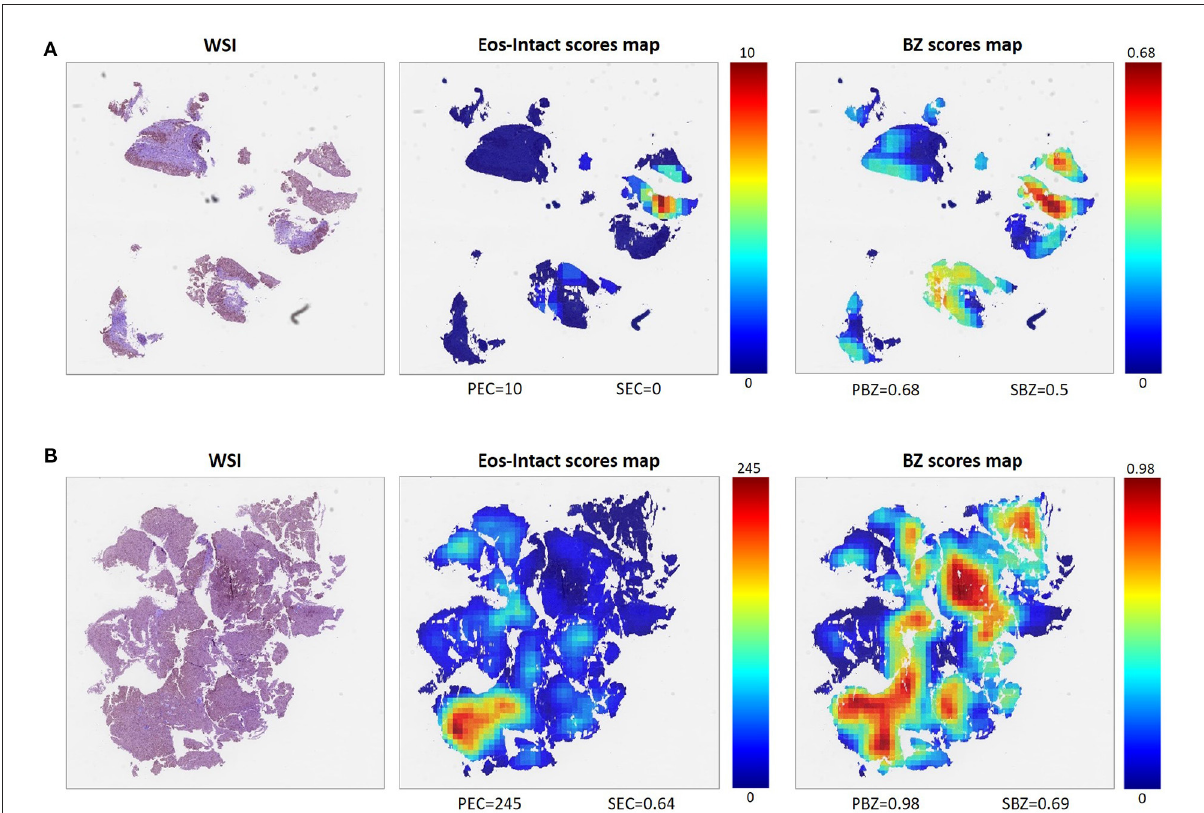
FIGURE3 Examples of two different WSIs (left) and their corresponding scores maps with scale for each score defined (middle, right). Each pixel in these maps represents one HPF, and the color of the pixel indicates the respective score. From the Eos-Intact scores map (middle), we extracted peak eosinophil count (PEC) and spatial eosinophil count (SEC). From the basal zone (BZ) score map (right), we computed peak basal zone (PBZ) and spatial basal zone (SBZ) scores. (A) Example of a WSI of a biopsy obtained from an EoE patient with inactive disease (PEC = 10). (B) Example of a biopsy obtained from a patient with active EoE (PEC =